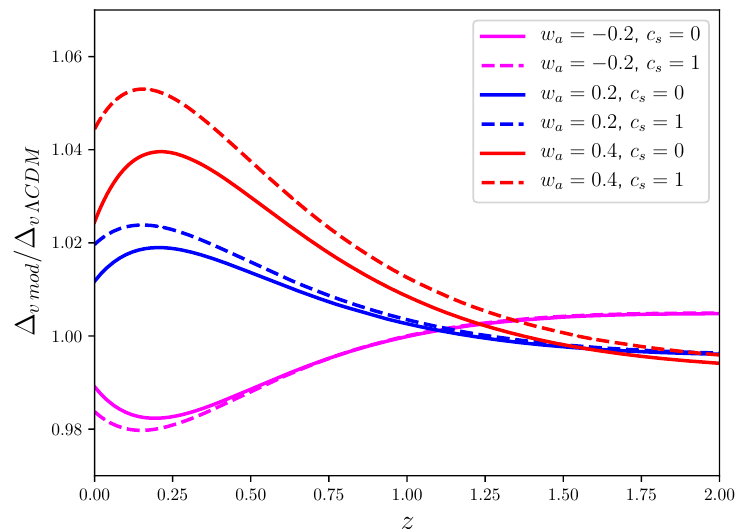
1 and Ω m 0 = 0.3 for all models. Note that, − < 1. de −